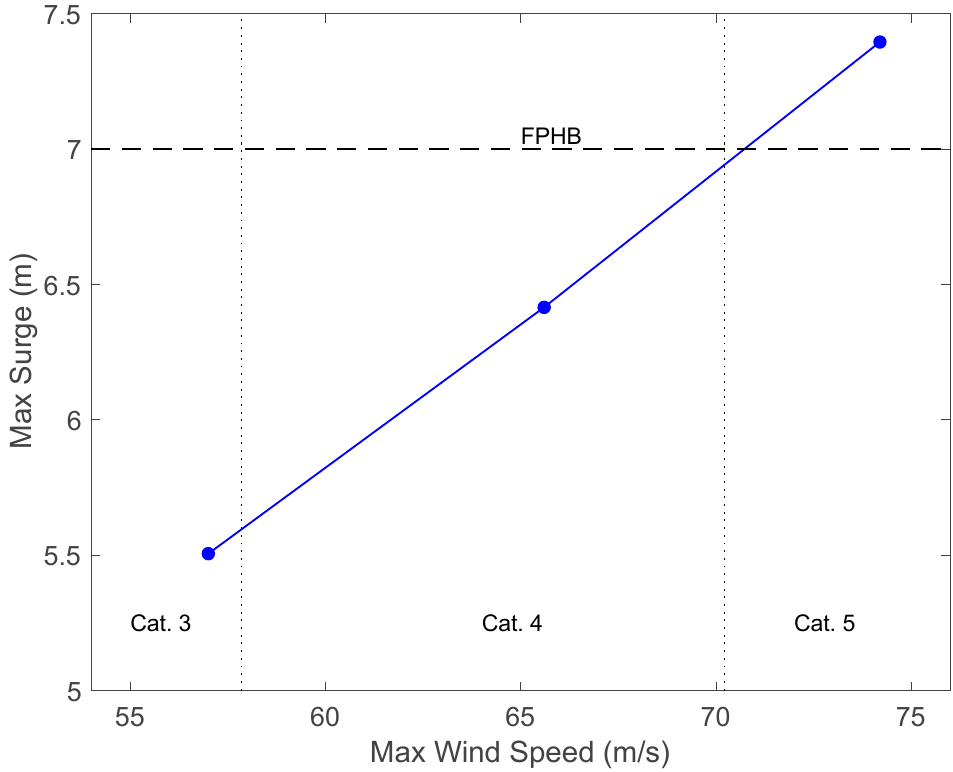
Figure 11. Maximum storm surge elevation at Providence [relative to mean sea level (MSL) versus maximum wind speed at hurricane landfall from simulations with varying strength Rhody forcing. The approximate elevation of the FPHB is shown by the horizontal dashed line. The vertical dotted lines denote the boundaries between Saffir–Simpson hurricane wind scale categories 3–5.